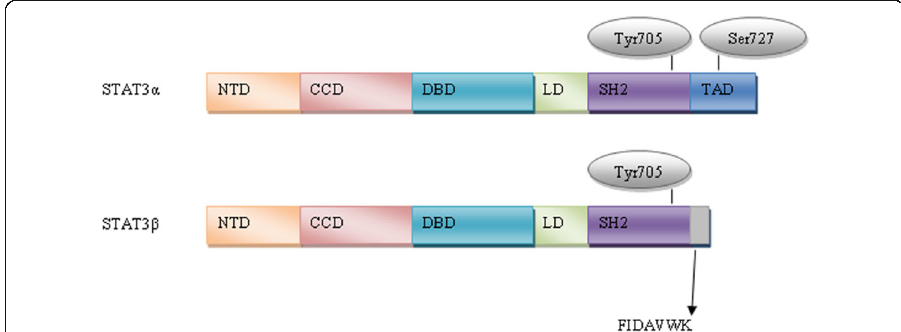
Fig. 1 Schematic overview of STAT3 α and β isoforms – NTD, NH2-terminal domain; CCD, coiled coil do- main; DBD, DNA-binding domain; LD, linker domain; SH2 domain; TAD, transcription activation domain.